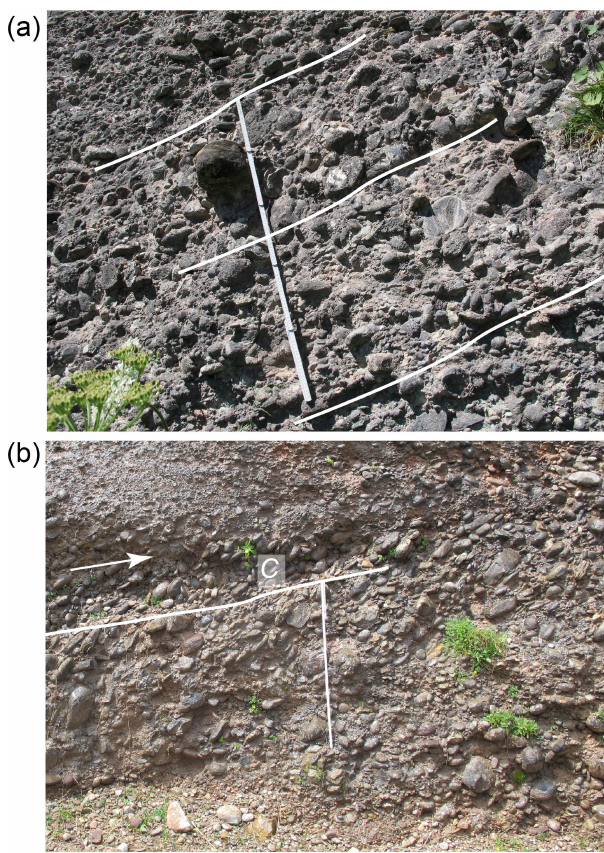
Figure 7. (a) Conglomerates at Rigi with no evidence for clast imbrication. White lines indicate the orientation of the bedding. (b) Conglomerates at Rigi with imbricated gravels to cobbles that are arranged as cluster bedforms ( C ). Arrow indicates paleoflow di- rection. White line refers to the bedding. Note the steep dip (>25 ◦ ) of the a – b planes of the imbricated clasts. See Fig. 2 for location and Table 1 for